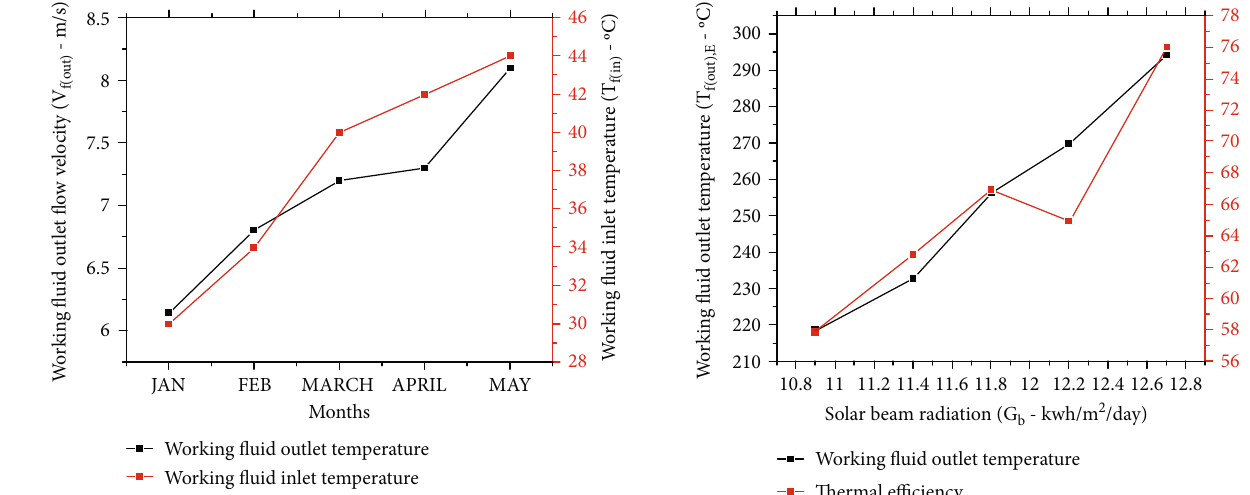
Figure 17: Behavior of working fl uid outlet temperature and thermal e ffi ciency with solar beam radiation.